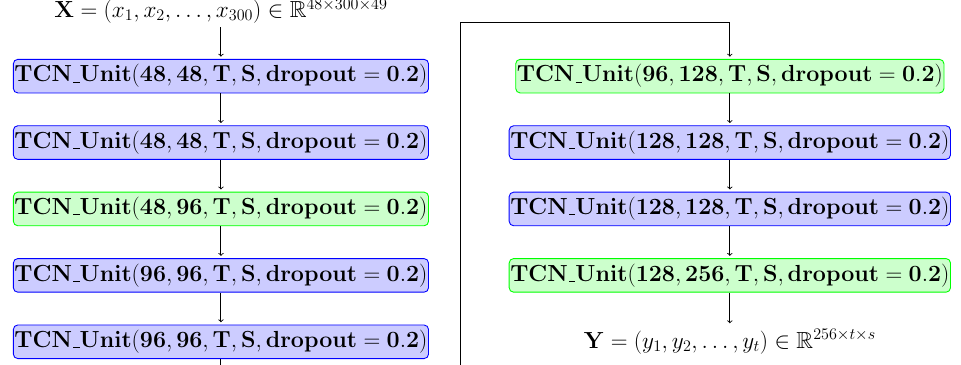
Figure 8. T represents the size of the temporal window, and S represents the size of the spatial window. For the blue blocks, the stride has the value 1, and for the green ones, the stride has the value 2. 300 represents the maximum number of frames, and 49 represents the number of analysed joints (results after the linear rearrangement described in Section 3.1.1). For each TCN type unit, the padding is determined based on the T and S